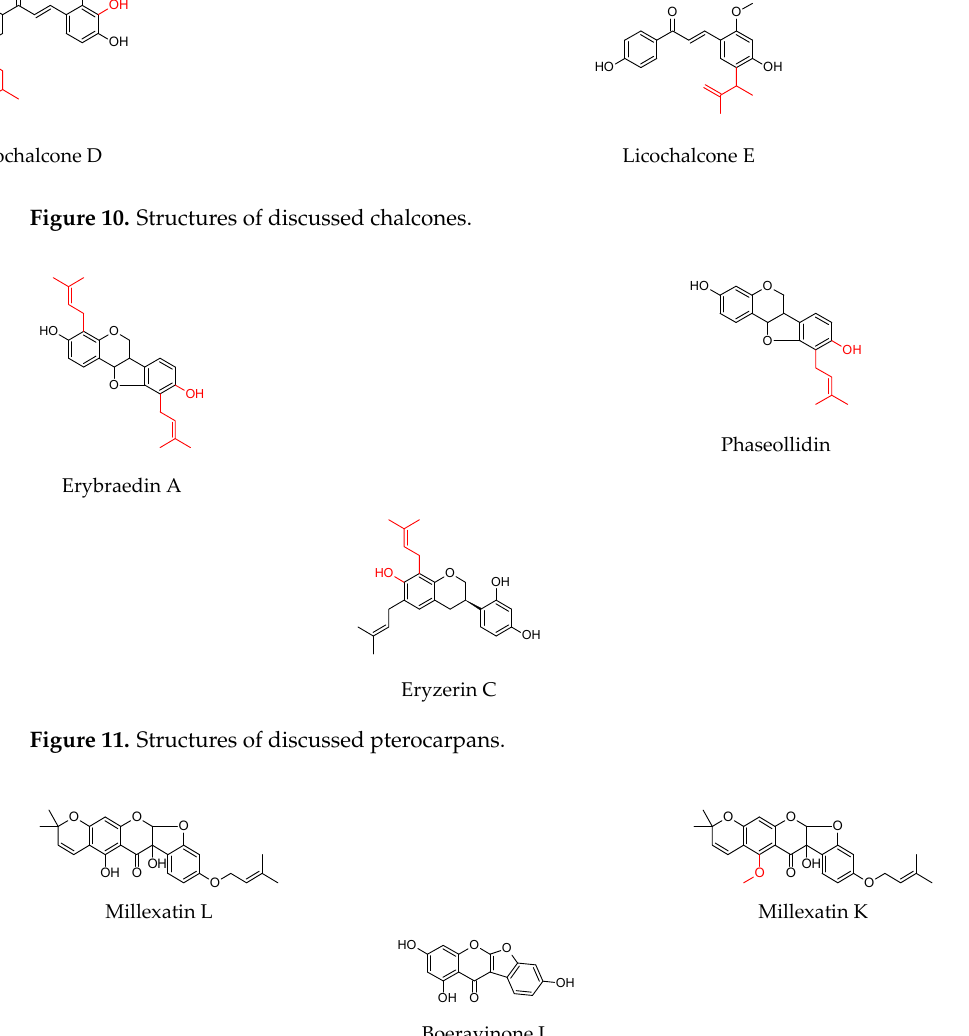
Figure 12. Structures of discussed coumaronochromones.